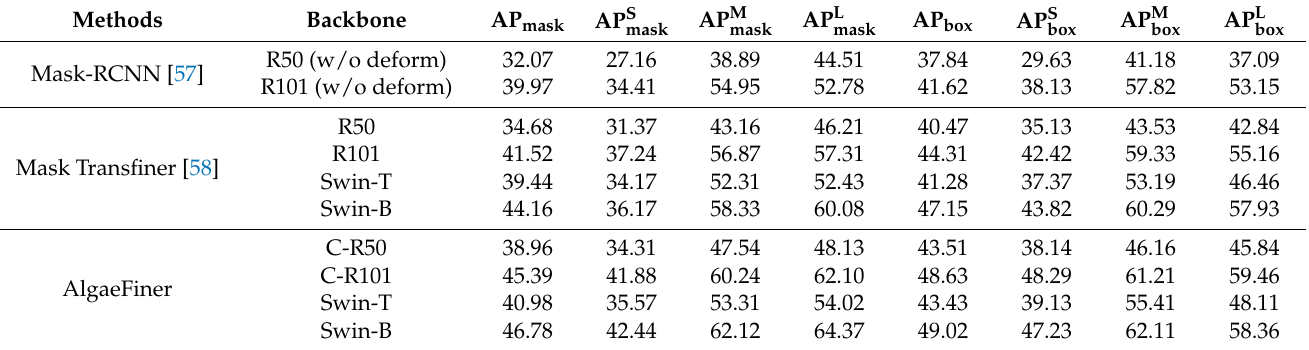
Table 4. Comparison performance of different models on AP.